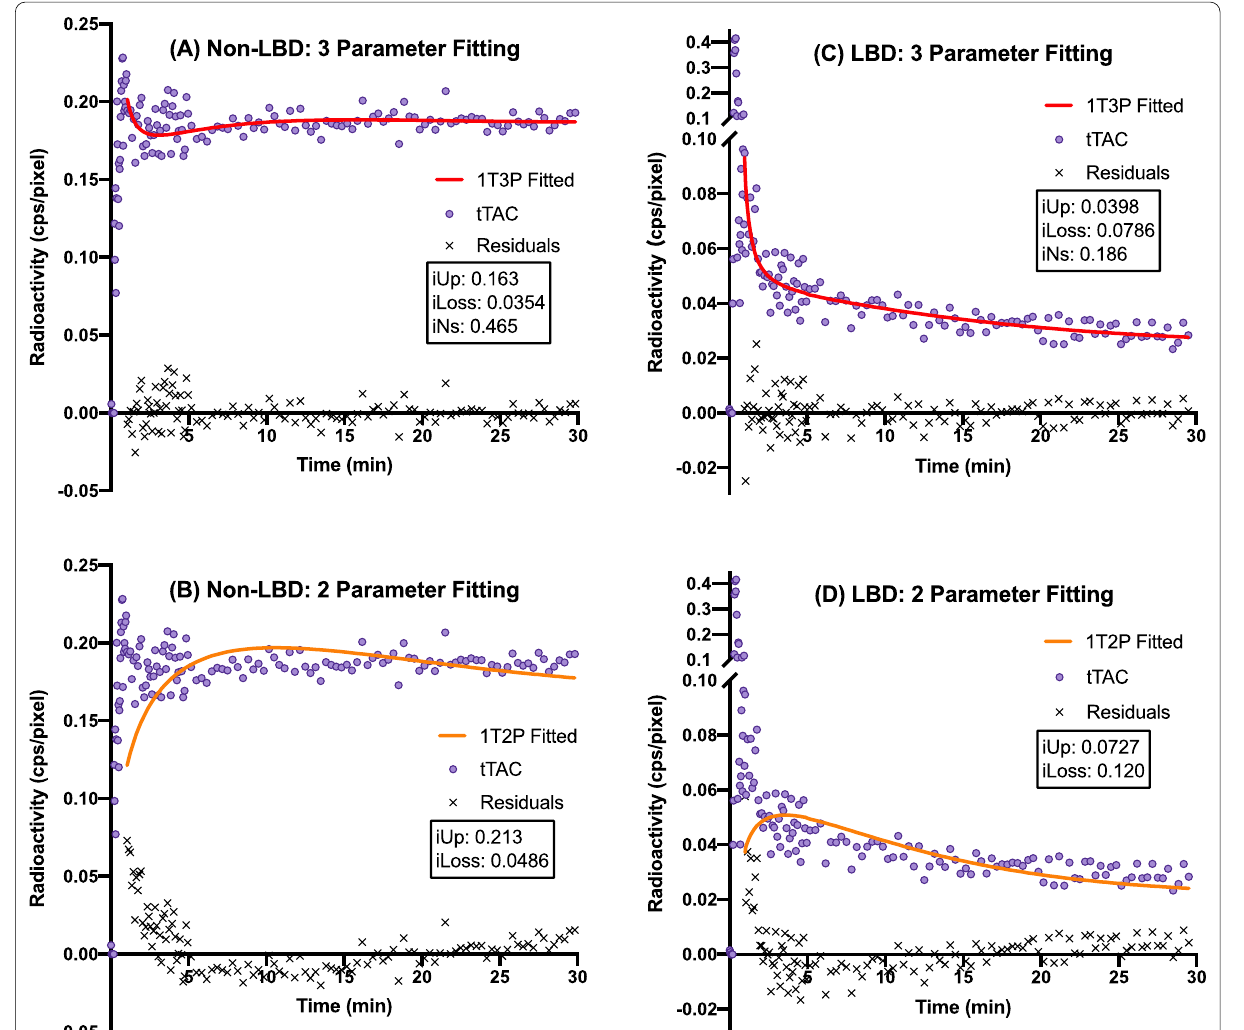
Fig. 1 The results of nonlinear least‑square fitting of the two kinetic models for two representative patients. A and B are obtained from a patient without LBD, while C and D are obtained from a patient with LBD. The tTACs were fitted with three parameters (1T3P: A , C ) better than with two parameters (1T2P: B , D ). See Additional file 1: Figs. 1 and 2 for the corresponding ROI TACs and